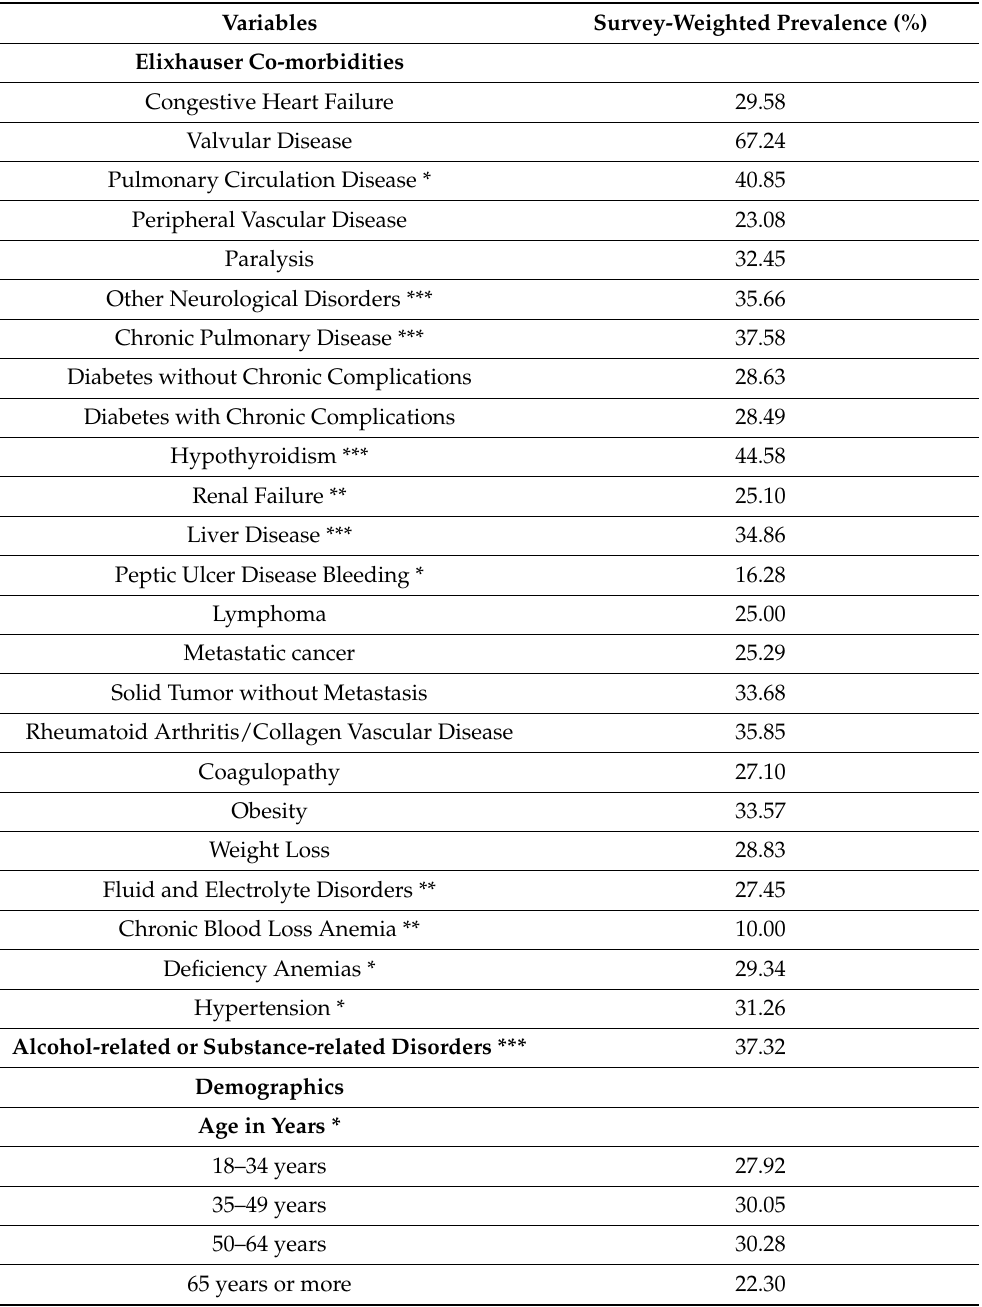
Table 2. Prevalence of any mental illness by patient and hospital characteristics of primary HIV discharges in the United